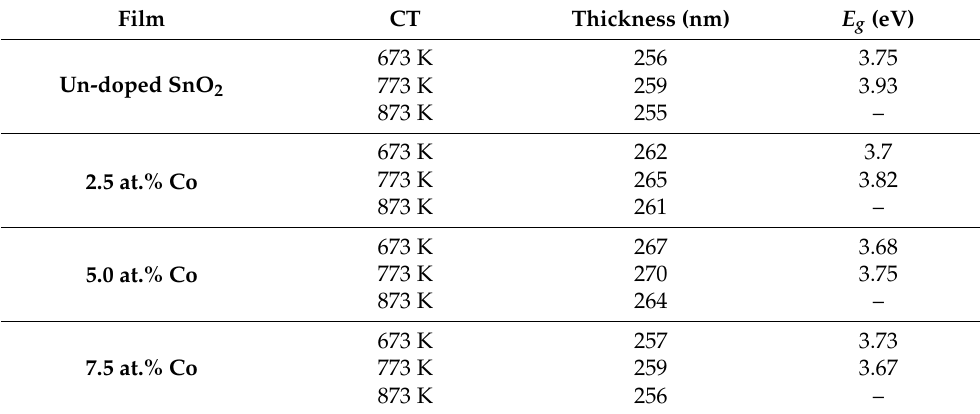
Table 2. Values of Films’ thickness and optical band gap ( E g